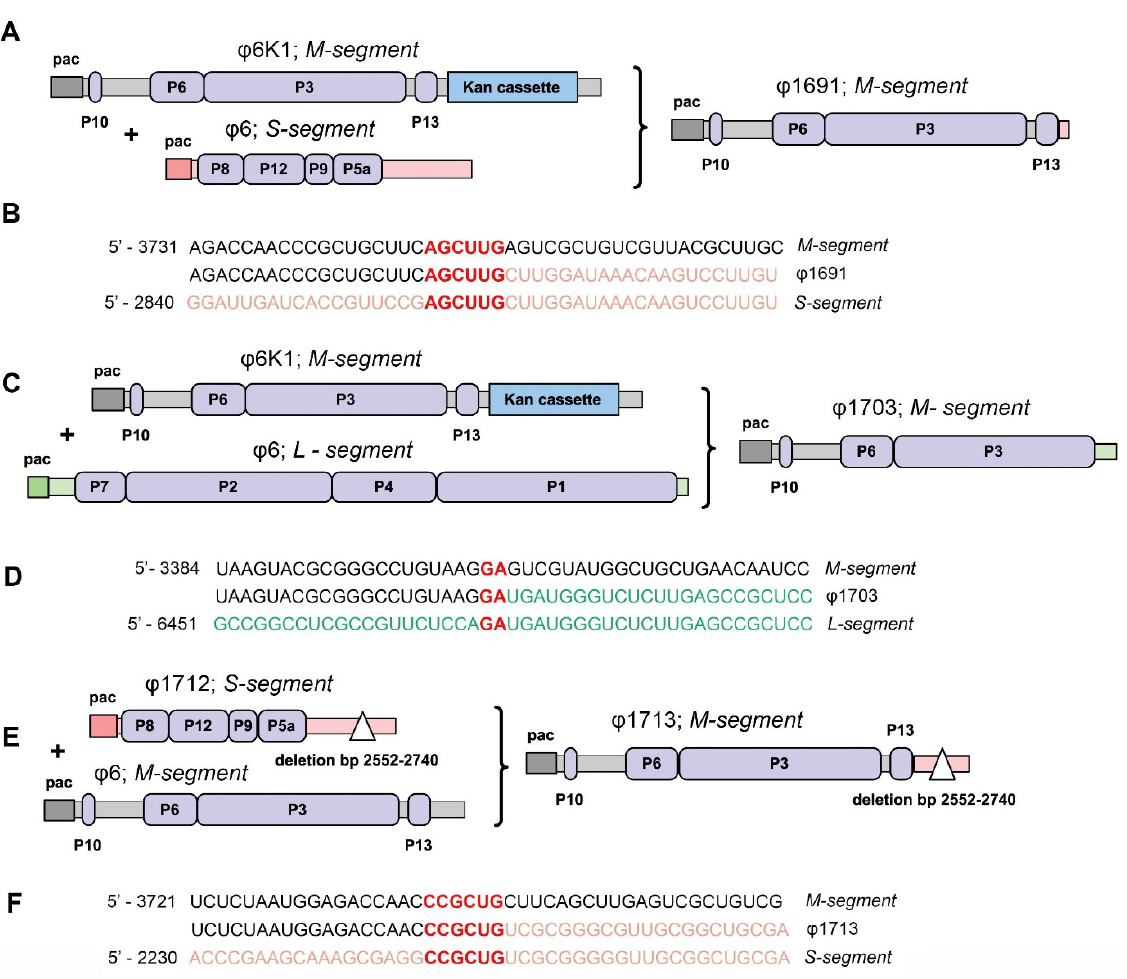
Figure 2. Recombination events facilitated by introduction of kan cassette structurally organized as a hairpin loop. The ϕ 6K1 recombinant virus contains the M-segment with a kan cassette. Isolation of clear plaques from unstable transducing virus confirmed the recombination between M and S or L segments ( A , C ). This stable isolated virus ϕ 1697 ( A , B ) did not have the kan cassette in the M-segment. The 3 (cid:48) end of M-segment of ϕ 6K1 (3754–5303 bp) was recombined heterologically with the 3 (cid:48) end of the S segment (2858–2948 bp). Only 6 bp of similarity existed between two